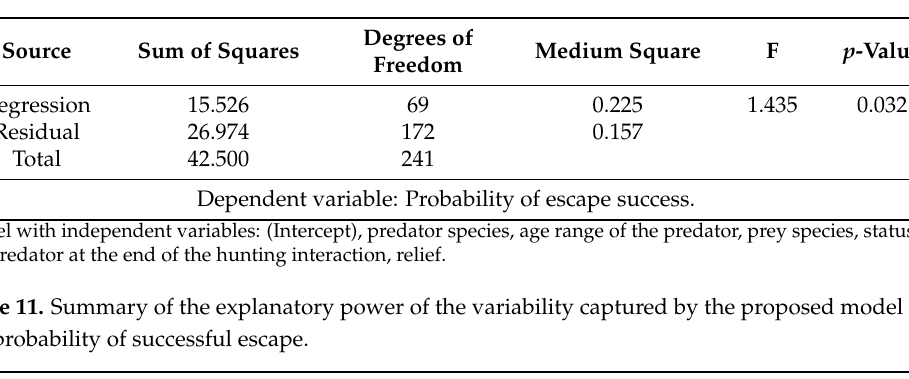
Levels Mode Mean